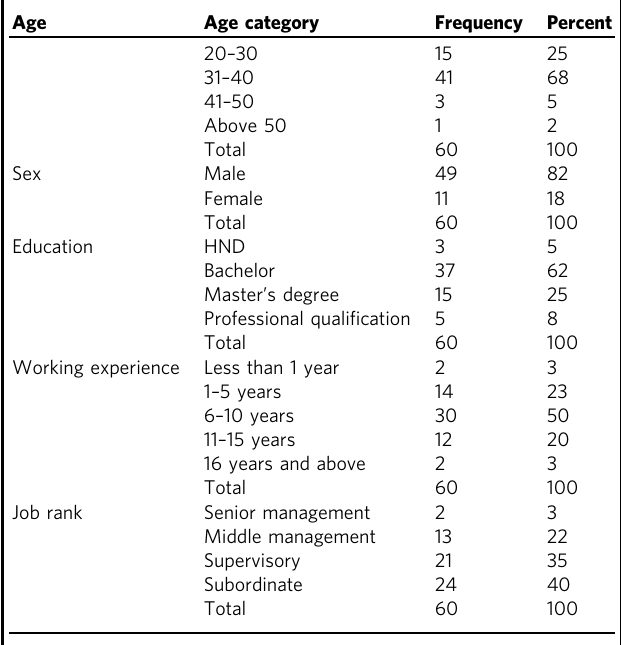
Table 1 Background information of the respondents.